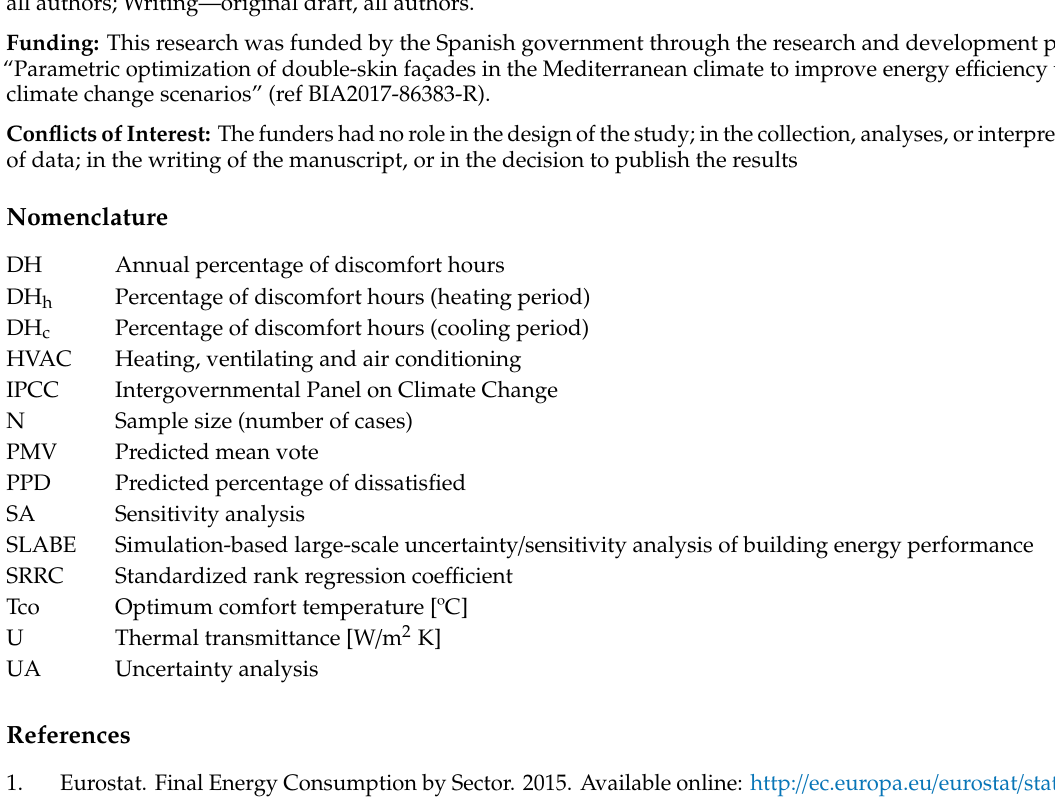
Table S1: Description of case